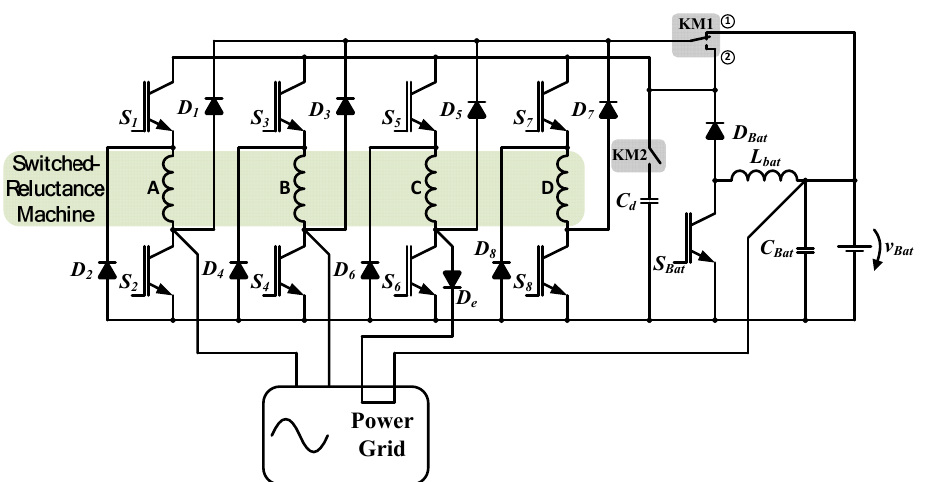
Figure 6. Non-isolated, bidirectional, single-phase unified power converter topology based on an SRM [9].